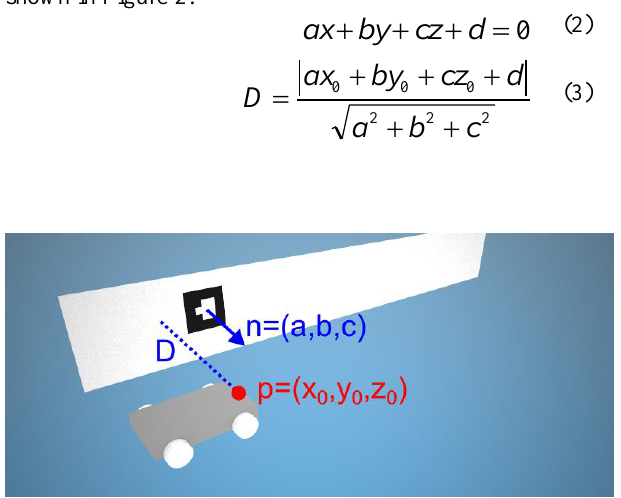
Figure 2. Calculation of the distance between the vehicle and the wall. The equation of the wall plane is defined by the plane with normal vector n(a,b,c). This plane can be calculated from the information provided by the transformation matrix of the marker (wall and marker are coplanar). The point p(x o ,y o ,z o ) is the centre of the camera, which is mounted on the vehicle. The distance between the car and the wall (D) is defined by the minimal distance between the point p and the plane defined by n.